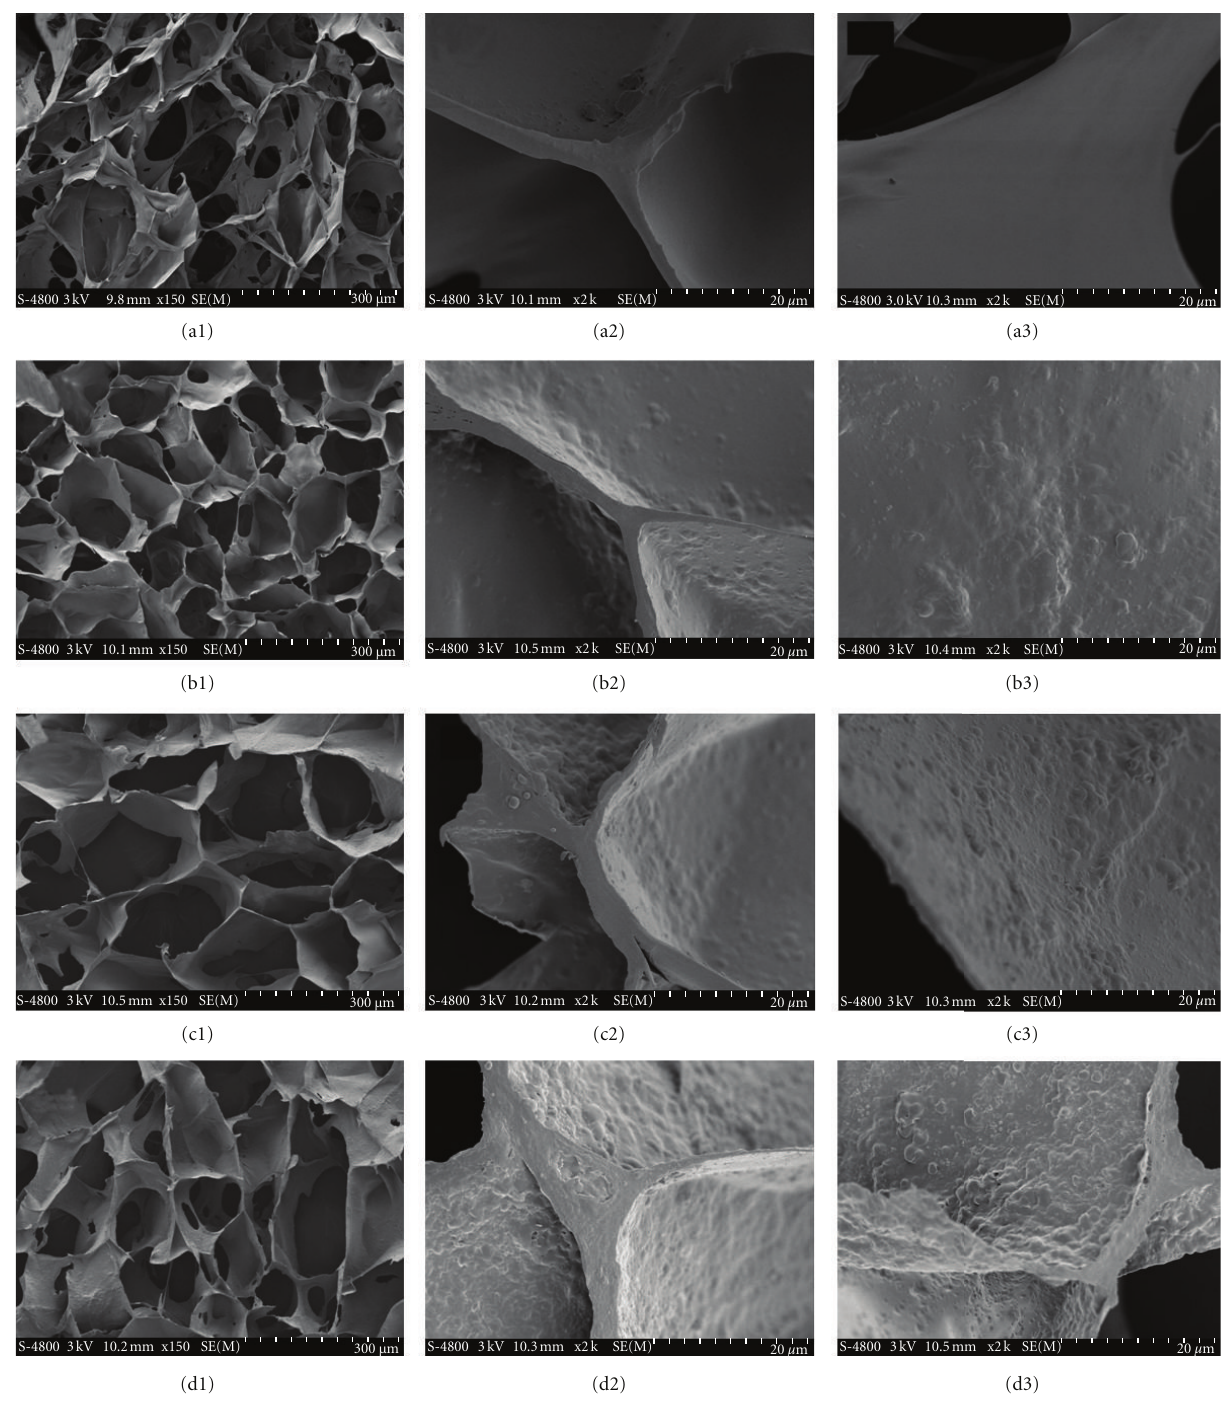
Figure 2: SEM images of porous collagen sca ff olds integrated with PLLA nanoparticles. (a1), (a2), (a3): Col:NP = 6 :0; (b1), (b2), (b3): Col: NP = 6:1; (c1), (c2), (c3): Col:NP = 6 :3; (d1), (d2), (d3): Col:NP = 6:6 (w:w).